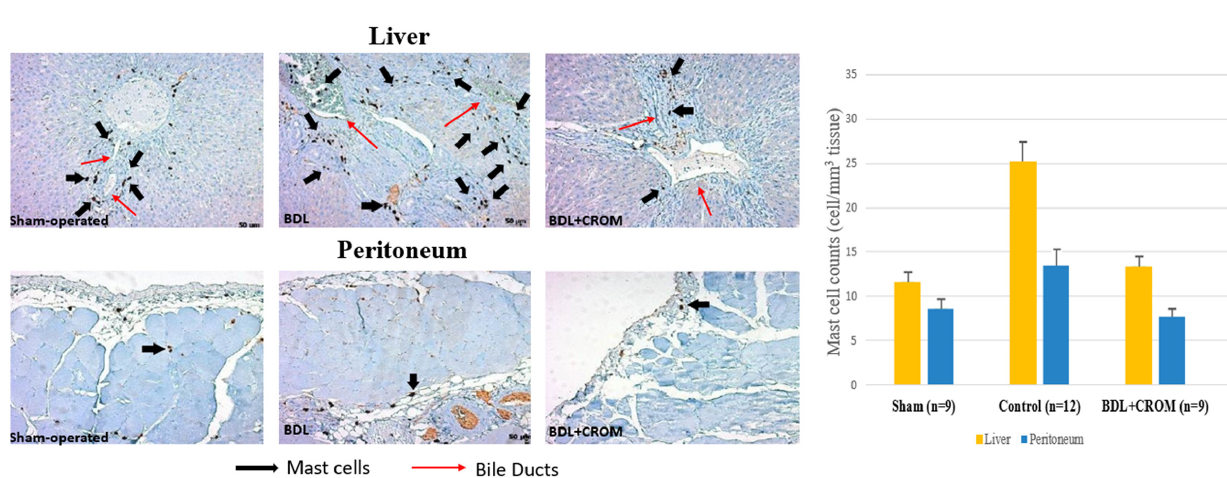
Figure 9. The peribiliary distribution of mast cells and changes of their counts in the BDL+CROM group compared to sham and control groups are seen. BDL, bile duct ligation; CROM, cromolyn